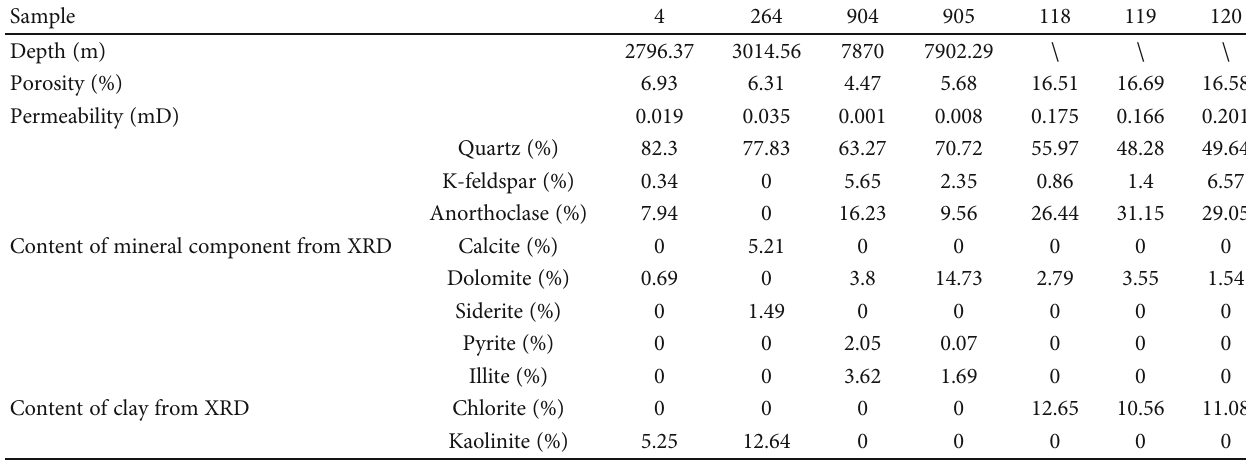
Figure 1: Location of the study area and the core wells in three di ff erent reservoirs. Table 1: Petrophysical parameters and mineral compositions of the seven tight